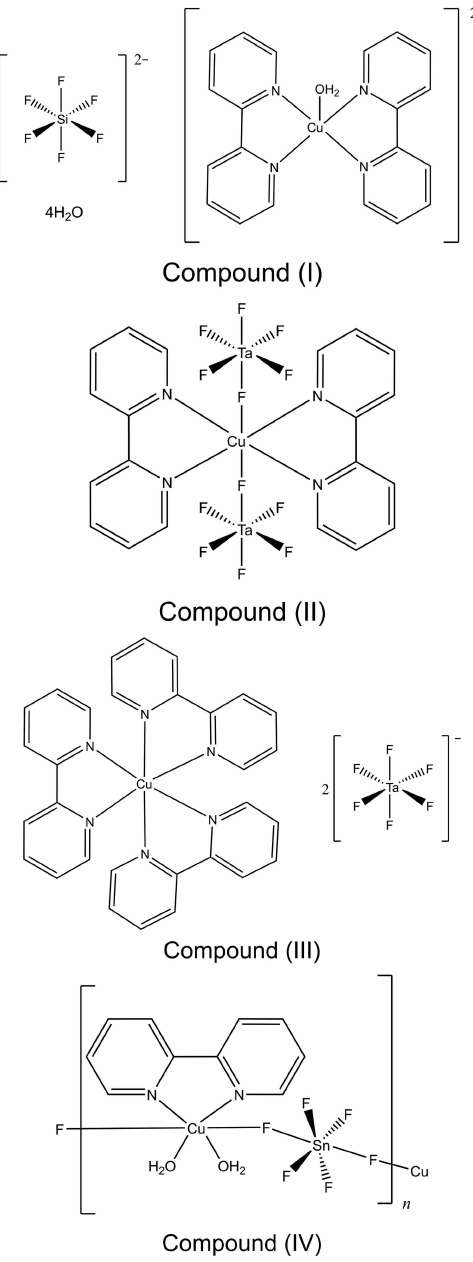
Figure 2 The molecular structure of one of the two independent molecules in (II). Ellipsoids of non-H atoms are drawn at 50% probability. H atoms are drawn with an atomic radius of 0.135 A˚